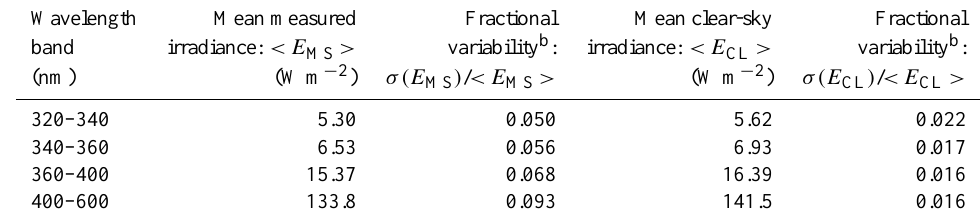
Table 1. Statistical characteristics of the irradiance dataset a .